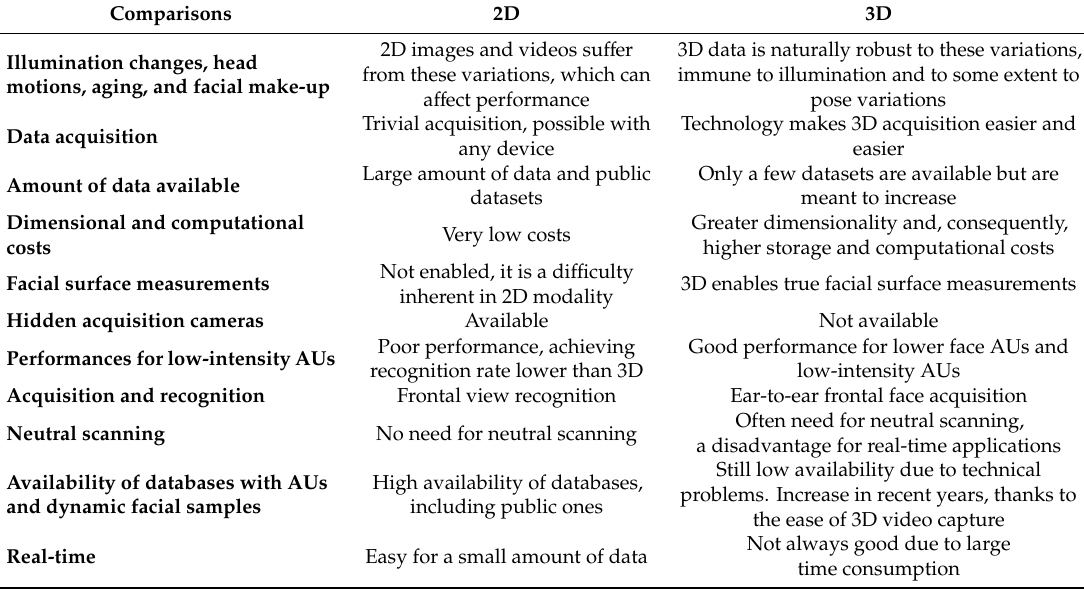
Table 7. Pros and cons of 2D and 3D